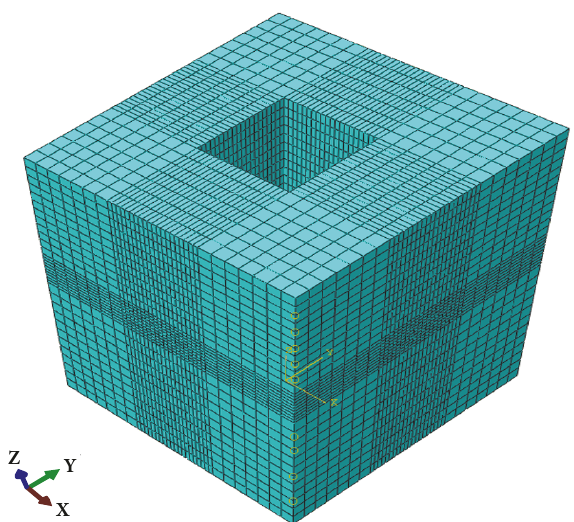
Figure 8: Schematic of the finite element mesh.